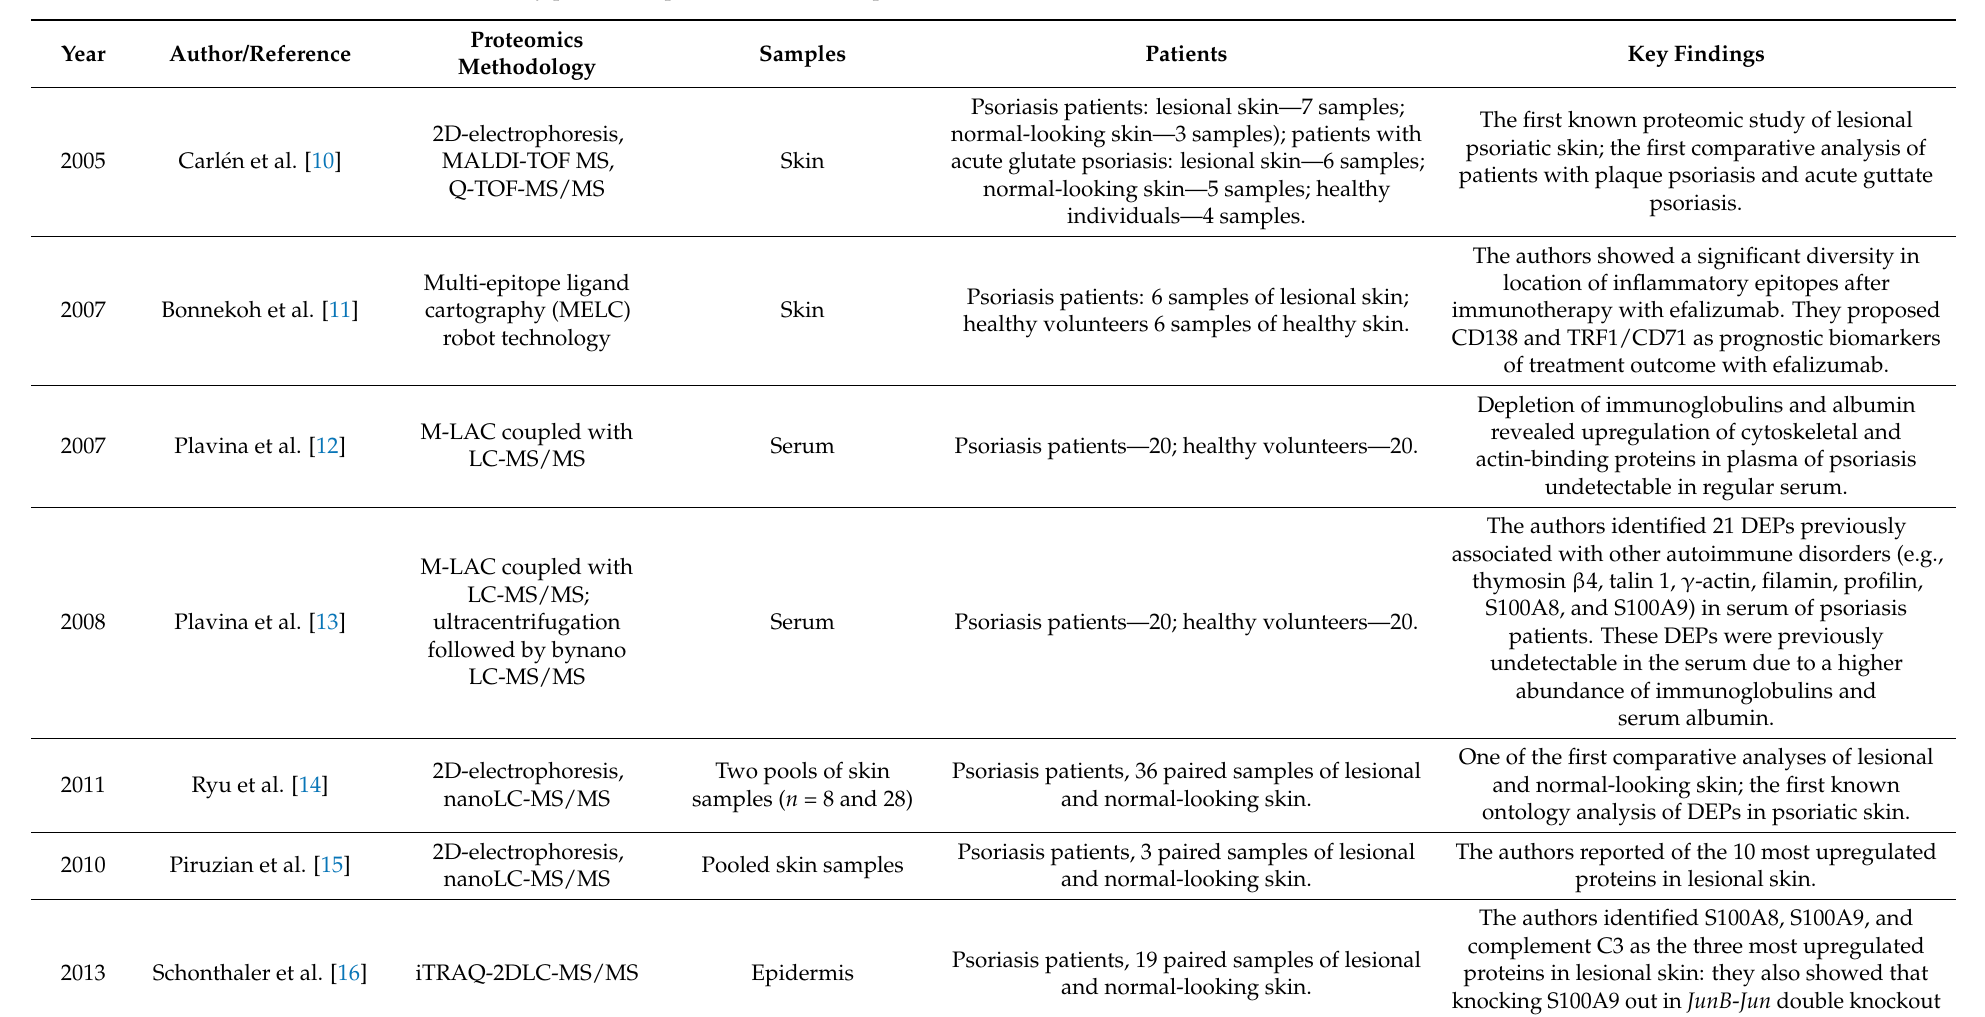
Table 1. Previously performed proteomic studies in